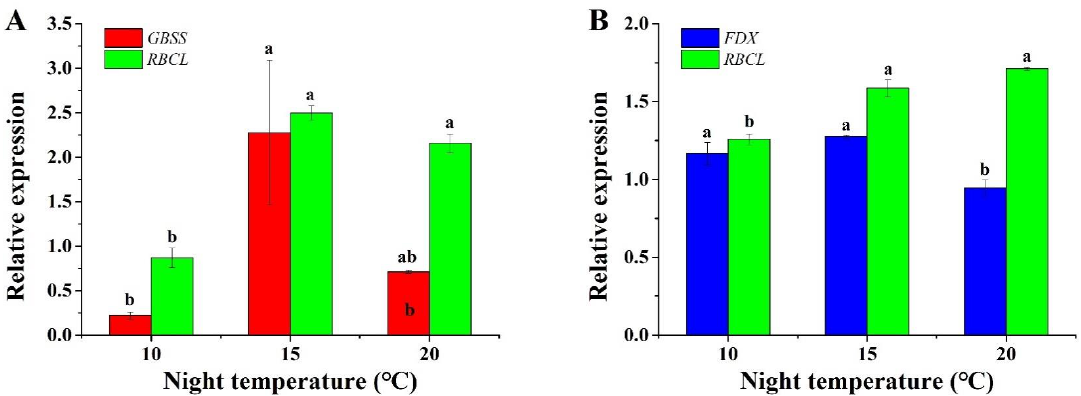
Figure 5. Effect of night temperature on the gene expression in A. membranaceus ( A ) and C. lanceolata ( B ) plug seedlings. GBSS: granule-bound starch synthase, RBCL: ribulose bisphosphate carboxylase large chain , and FDX : ferredoxin . The 18S and β -Actin were used as the housekeeping genes in A. membranaceus and C. lanceolata , respectively. Data are presented as the mean ± standard error (n = 3). Different letters (a and b) indicate significant differences among treatments by Duncan’s multiple range test at a 0.05 level.